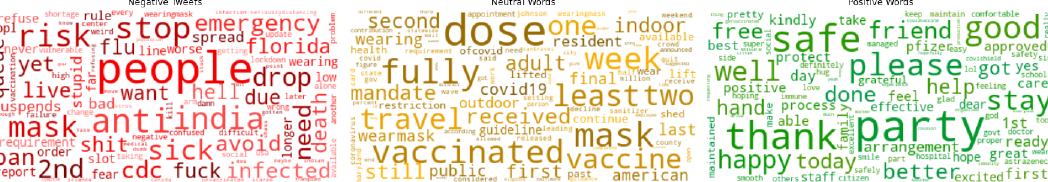
Figure 13. Combined top frequency words on Twitter Dataset 2 on healthy